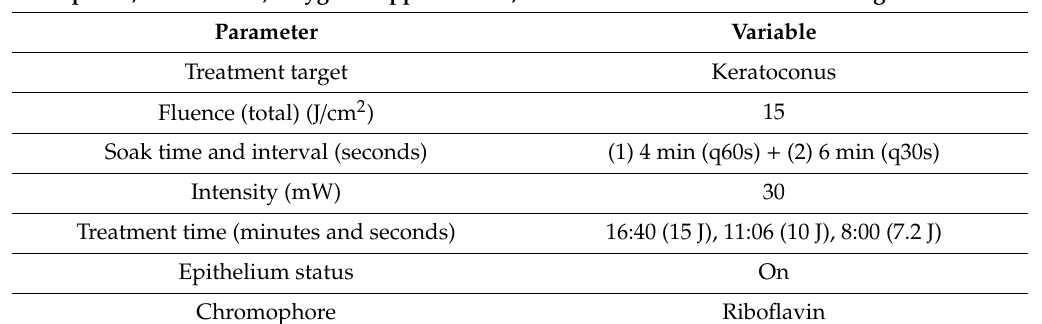
Table 1. Epithelium-on(epi-on),accelerated,oxygen-supplemented,customizedcornealcross-linkingmethods. Epi-On, Accelerated, Oxygen-Supplemented, Customized Corneal Cross-Linking